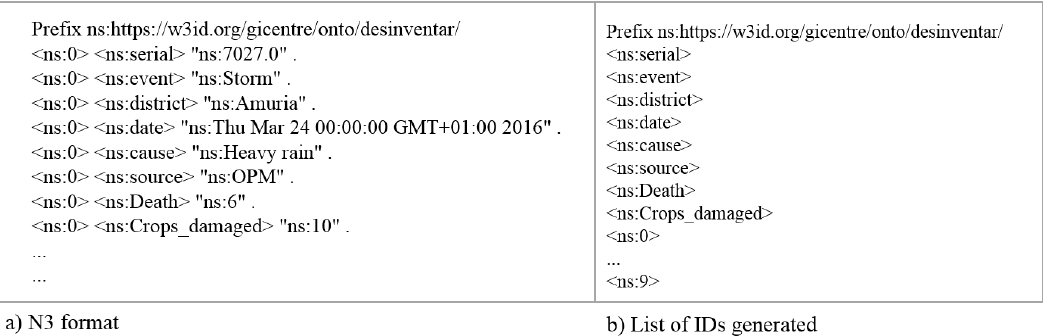
Figure 3. Data extracts.